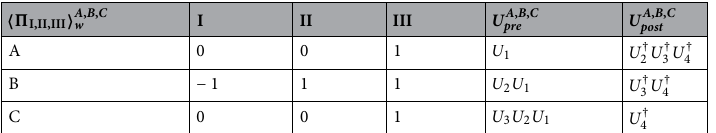
III ψ A , B , C pre U A , B , C pre | � = | �